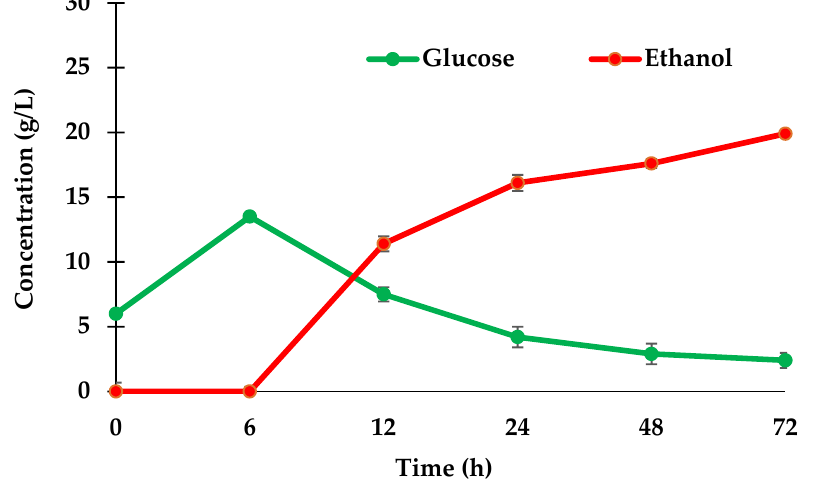
Figure 3. Effect of glucose content on ethanol production of pretreated sugarcane bagasse.